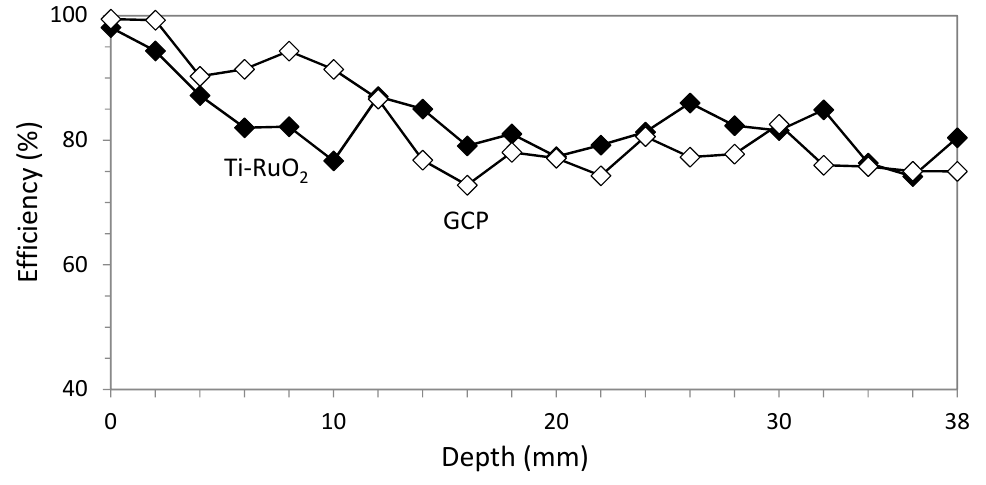
Figure 7. Comparative efficiency results for studies 1 and 2. Circular section specimens. ECE efficiency average with Ti-RuO 2 mesh was 82.79% against 82.60% with GCP anodic